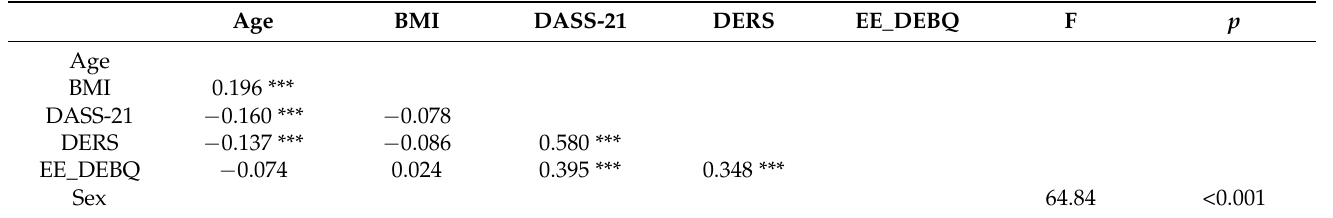
Table 2. Relationships between all the variables of interest.